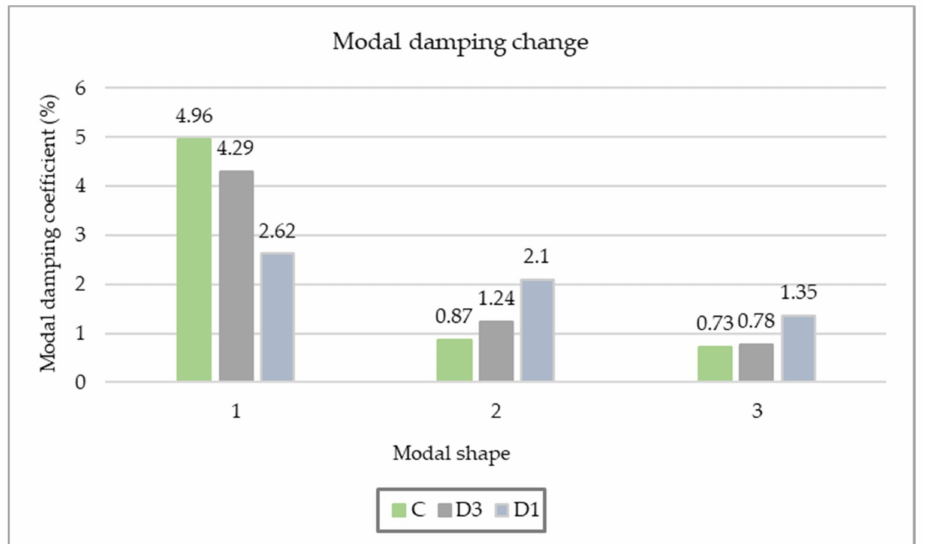
Figure 7. Change of damping coefficient value on beams C (control beam), D1 (steel surface loss 7.77%, maximum crack width 5.0 mm) and D3 (steel surface loss 7.65%, maximum crack width 1.0 mm) (author processing based on